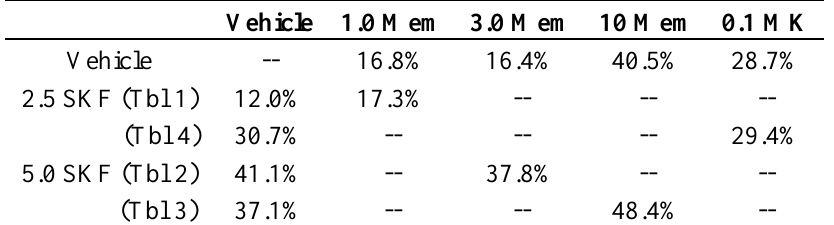
Table 5. Summary of data from the Tables 1–4. Percent decrease in the consumption (g/kg/day) of ethanol during treatment with SKF 38393 and either memantine or (+)-MK-801 compared to the value during vehicle treatment are